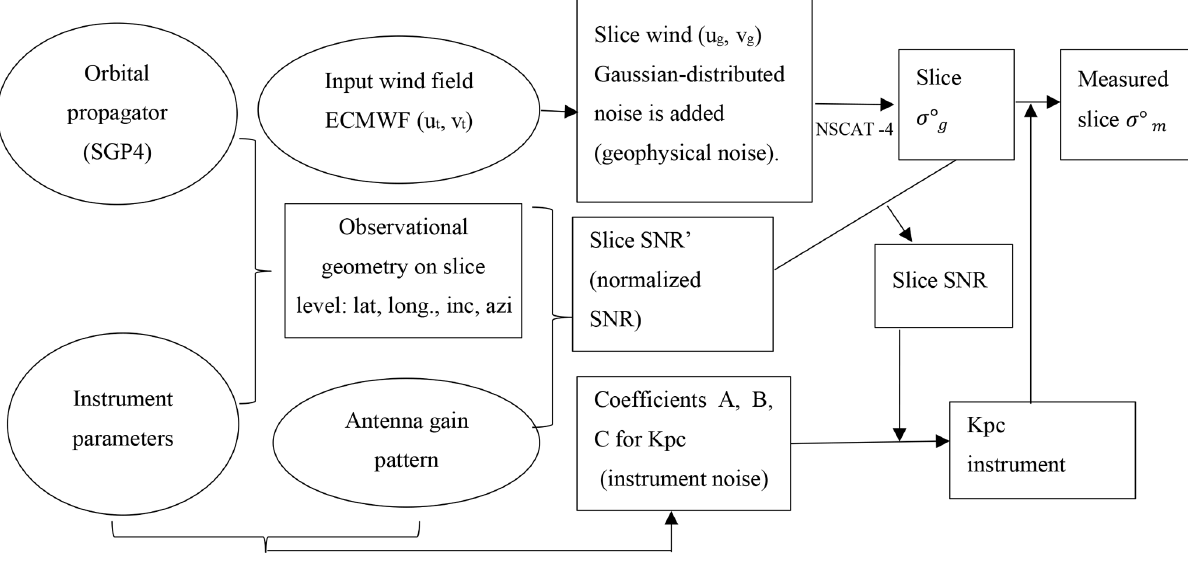
Figure 6. The workflow for generating L1B simulation